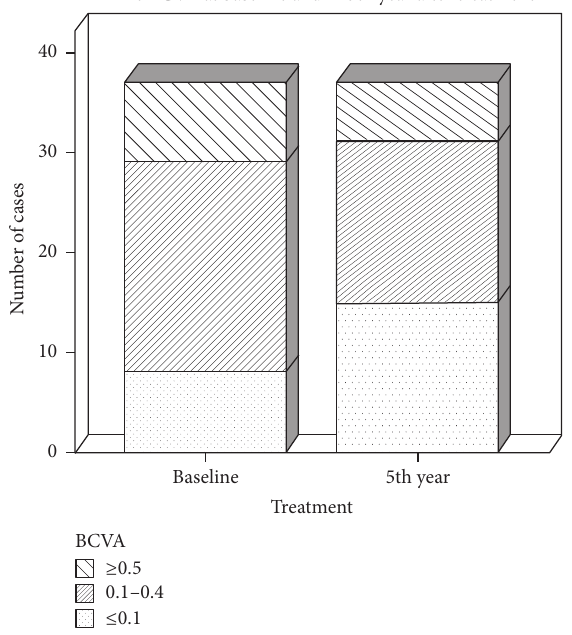
Figure 1: The distribution of the mean BCVAs before treatment and 5 years after treatment.